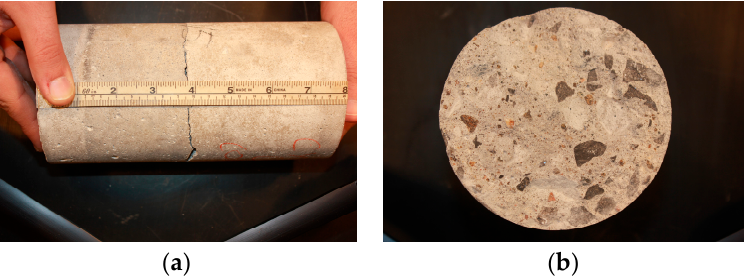
Figure 3. Broken specimen under tension using pressure-tension apparatus: ( a ) Elevation view; ( b ) Cross-sectional view. Table 2. Tensile strength of concrete exposed to ambient conditions for two years. Specimen No.